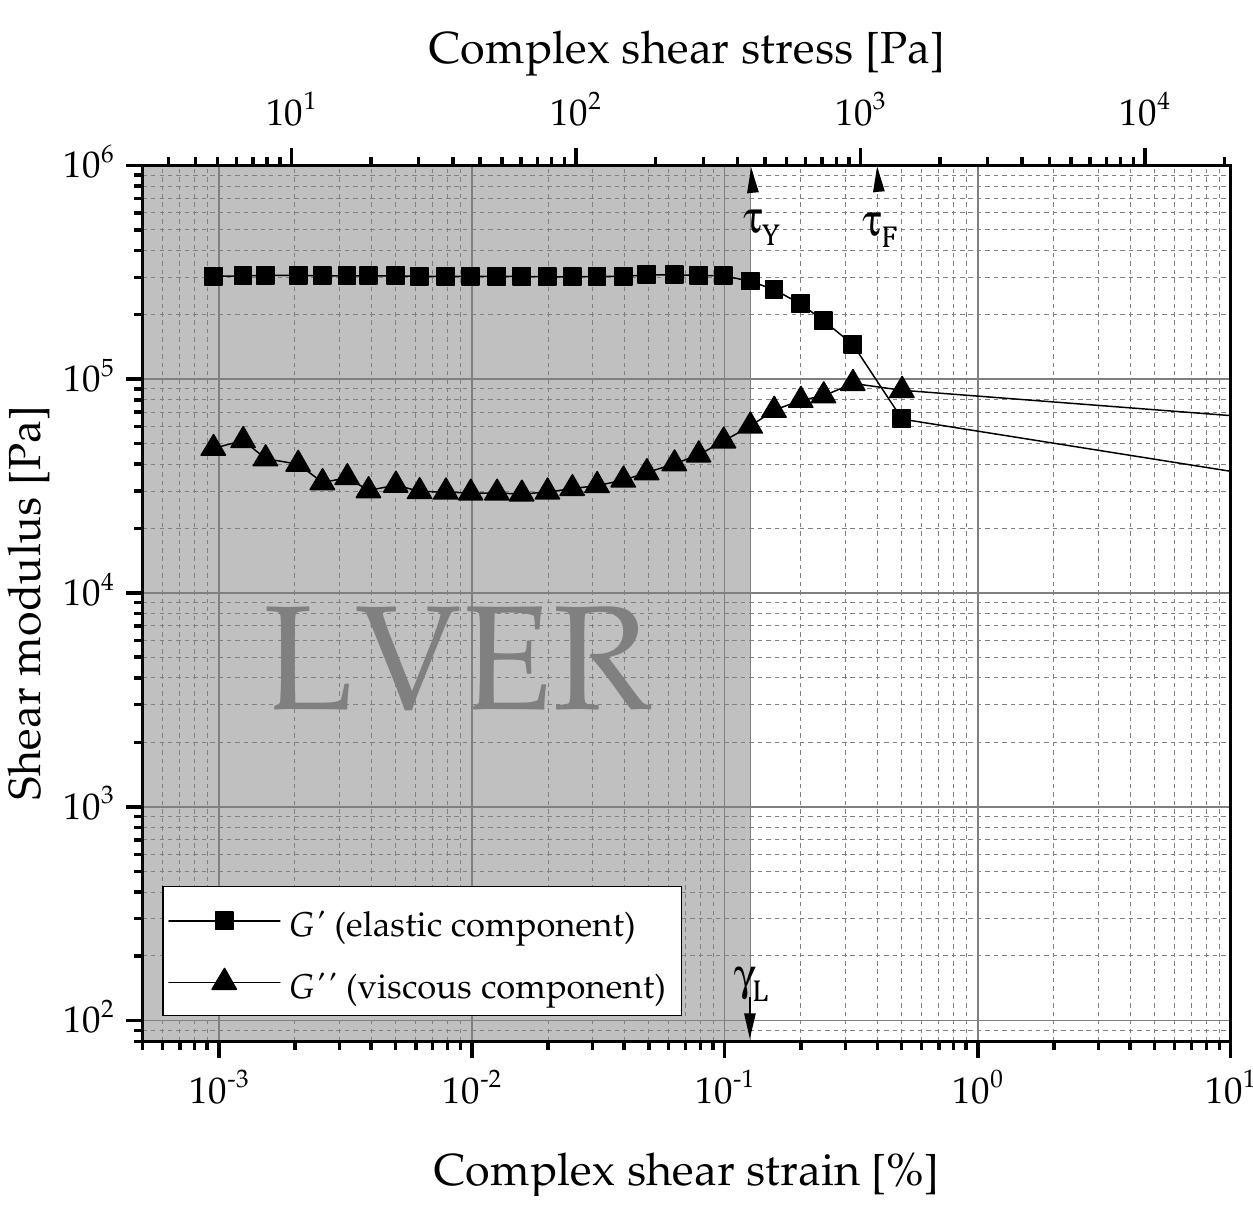
Figure A4. An illustration of an analysis of an amplitude sweep. As an example, the strain-controlled amplitude sweep of a 10-IPM-organogel is shown, measured at 1 Hz within a shear range of 0.001% to 1% at 37 ◦ C. The analyzed parameters γ L , τ Y , τ F , and LVER are marked. The end of the LVER is called the linearity limit. It is determined by G (cid:48) , the elastic component of the sample, as it shows a plateau within the LVER. Following DIN 1810-2, the last value of G (cid:48) , which is within a 10% range of the plateau G (cid:48) , is the end of the LVER. The related shear strain is the linearity limit γ L and the related shear stress is called the yield stress or yield point τ Y . When the sample starts to flow, G ”, the viscous component, outweighs the elastic component, which is why it is called the flow point τ F . By definition, this is the intersection point of G (cid:48) and G ”, and the required stress for the sol–gel transition is the flow stress τ F .